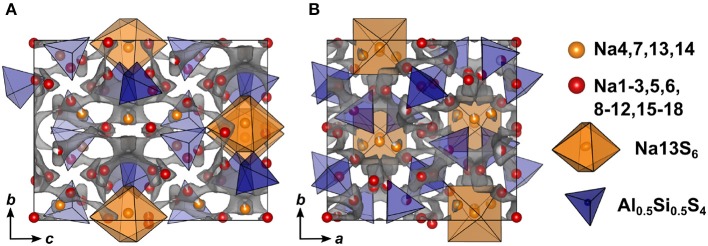
Crystal structure of Na9(AlS4)(SiS4) along a
(A) and c
(B) direction. The bond valence energy landscape at isoenergy value of −2.60 eV is drawn in gray (Eminglobal=-4.02 eV, Eminpath=-3.86 eV, Emigpath=-2.64 eV, ΔE3D = 1.22 eV).